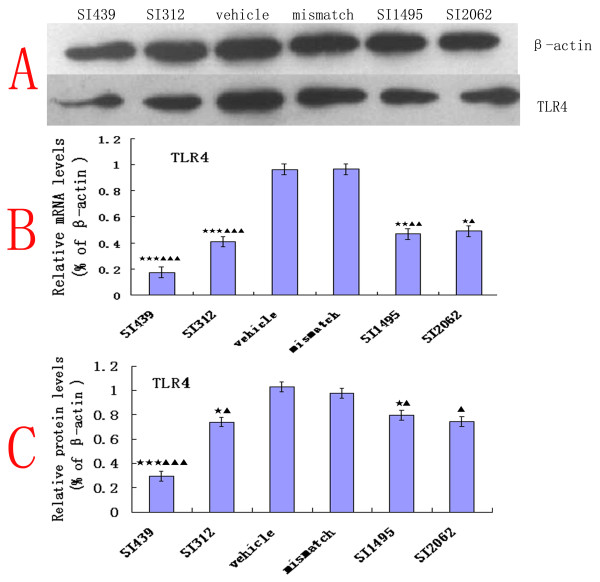
Molecular down-regulation of TLR4 mRNA and protein upon treatment with siRNA. (B) TLR4 mRNA levels in microglial cells line (HAPI), normalized to β-actin, were significantly reduced in TLR4 siRNA (SITLR4) versus mismatch siRNA- and vehicle-treated cells 24 h after transfection. siRNA439 was the most effective at knocking down TLR4 expression(n = 4, ANOVA1w, P < 0.001, post hoc Dunnett testing, df = 3, F = 1.08). (A) The TLR4 protein levels detected by western blotting analysis in HAPI 48 h after transfection, normalized to β-actin. (C) TRL4 protein levels were significantly reduced following treatment with TLR4 siRNA (SITLR4) compared with vehicle or mismatch siRNA treatment. Each data point represents at least three independent experiments. Values are presented as mean ± SEM. *P < 0.05, **P < 0.01, ***P < 0.001 vs. vehicle-treated cells; ▲P < 0.05, ▲▲P < 0.01, ▲▲▲P < 0.001 vs. mismatch siRNA-treated group.